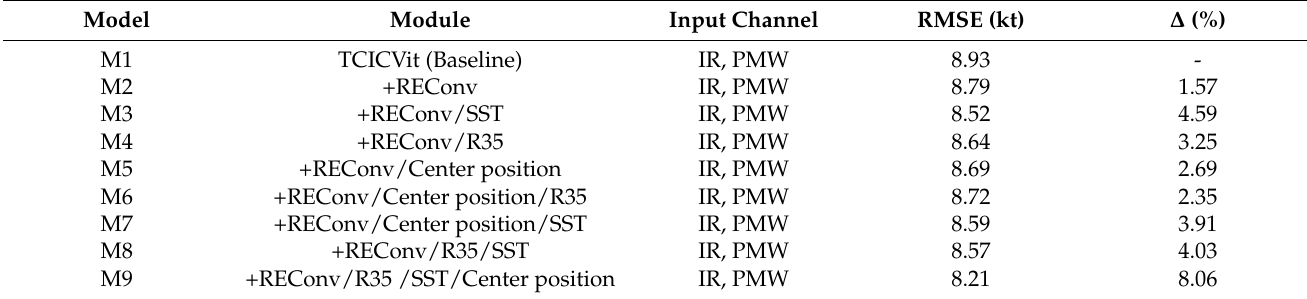
Table 6. Same as Table 5 but for fusion of IR and PMW remote sensing data.